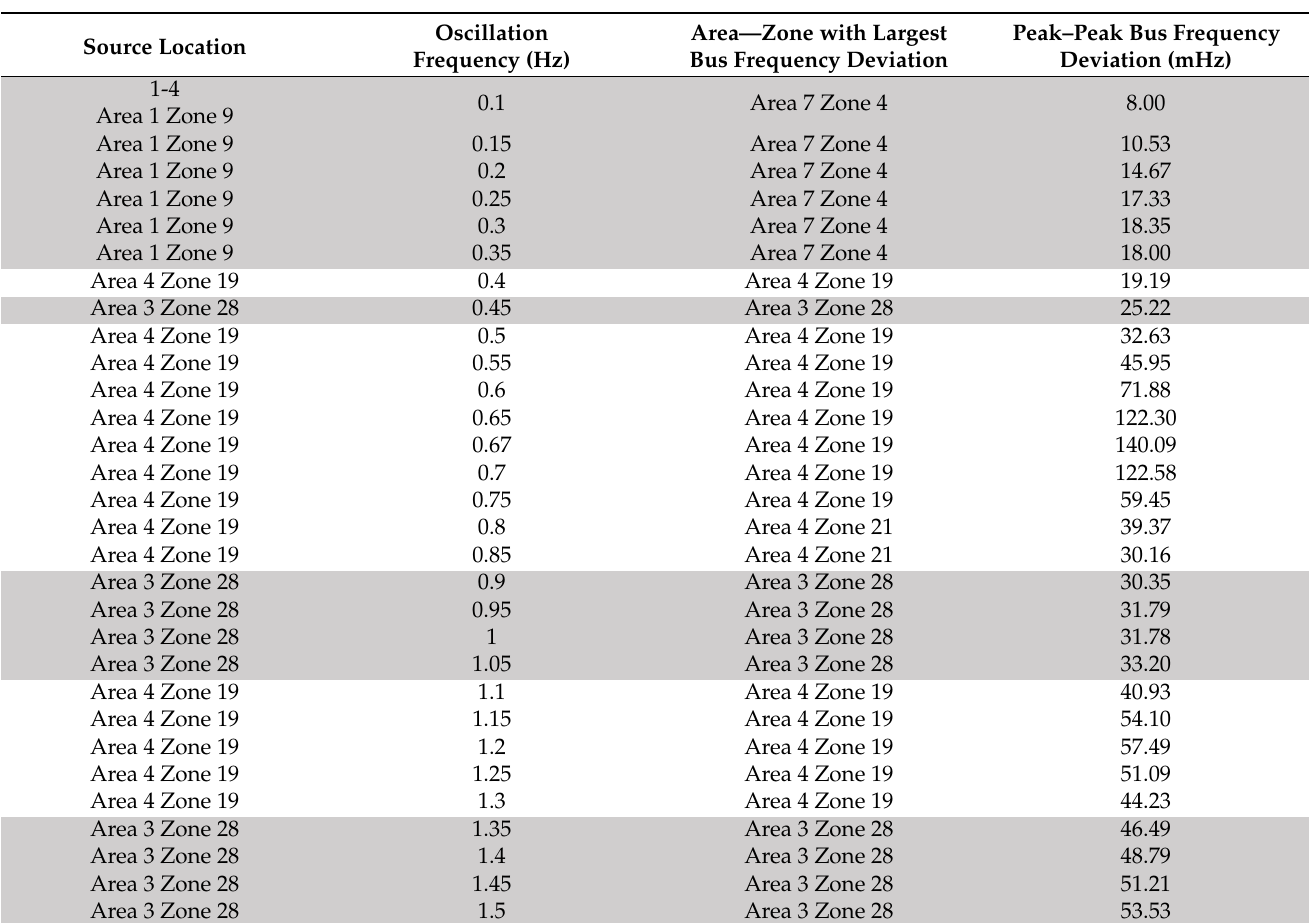
Table 4. The critical areas/zones under different frequency range based on two-dimensional